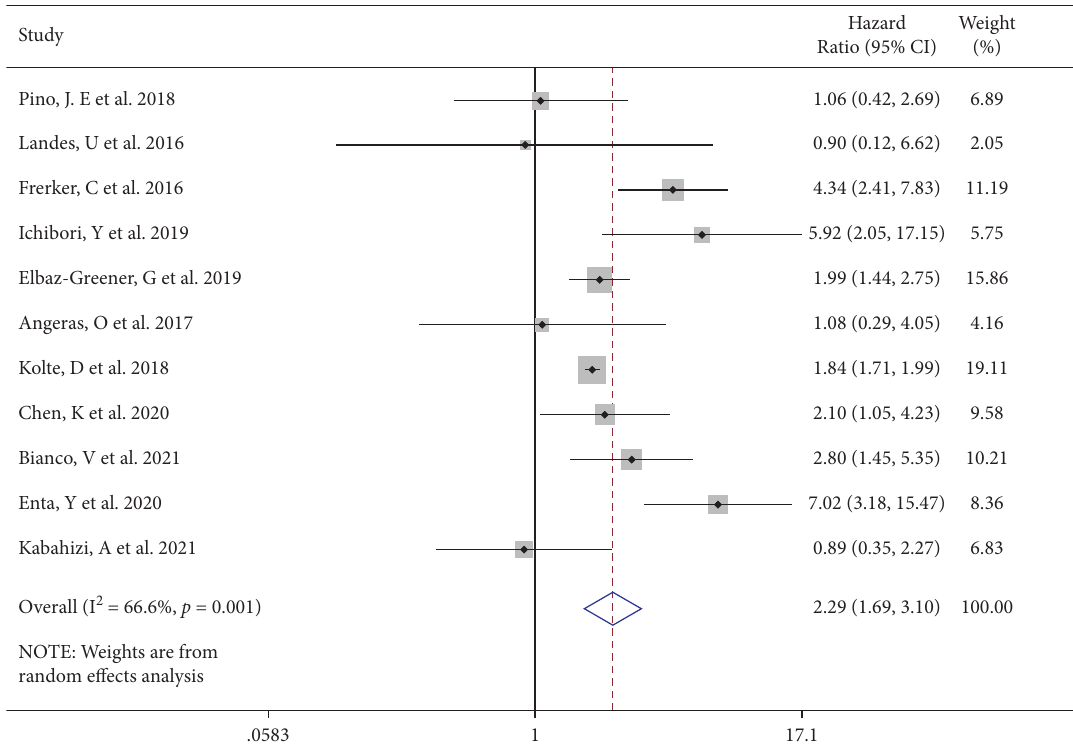
Figure 2: Forest plot showing the 30-day mortality of the emergent TAVI increased. CI, confidence